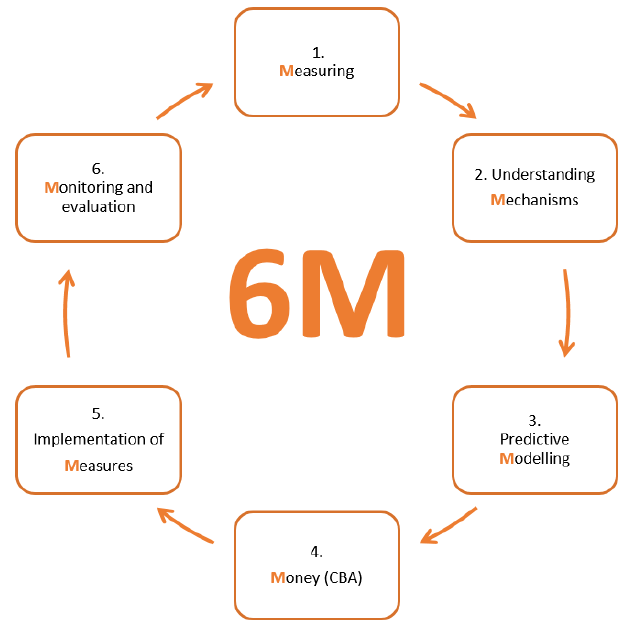
Figure 2. The 6M approach to land subsidence. The six steps are meant to be taken sequentially in a repeating loop, if necessary. CBA = cost benefit analyses. Image design by Welmoed